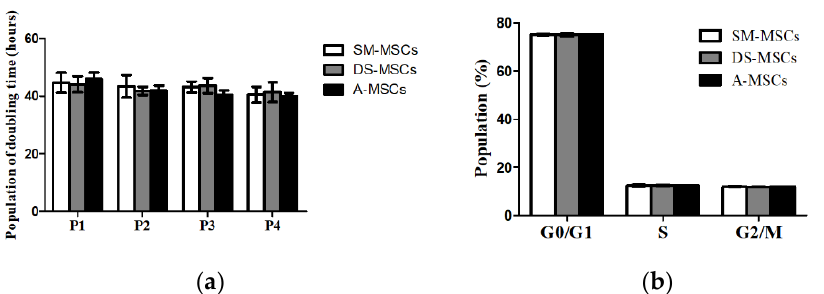
Figure 2. Cellular proliferation and cell cycle analysis of skeletal muscle (SM-MSCs), dermal skin (DS-MSCs), and adipose tissue (A-MSCs). ( a ). Population doubling time (PDT) analysis was performed in SM-MSCs, DS-MSCs, and A-MSCs. There was no significant difference during the passage. ( b ). The portion of the cell cycle was analyzed in SM-MSCs, DS-MSCs, and A-MSCs. The cell cycle arrest and DNA replication were similar in all three types of MSCs. The values were expressed as mean ± SD of four independent experiments.